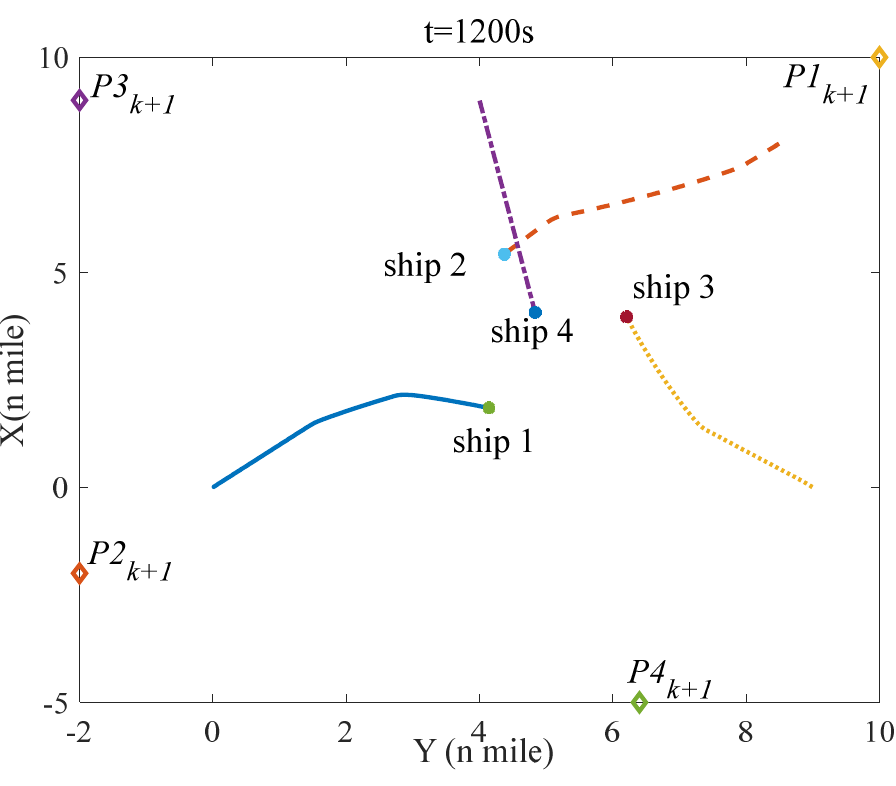
Figure 13. The situation of four ships at t = 600 s in scenario 2.